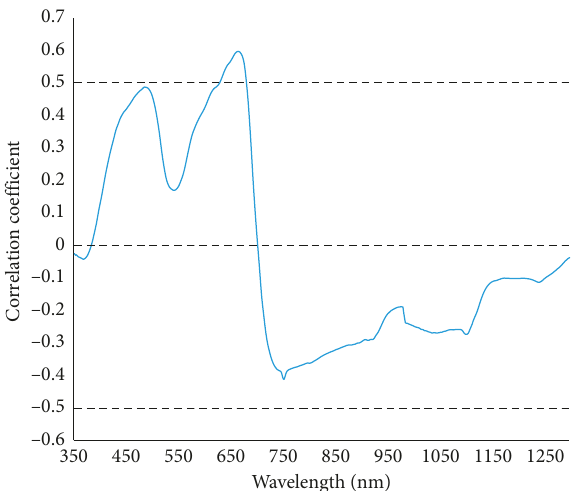
Figure 4: Curve of correlation coefficient between spectral re- flectance and severity of disease.